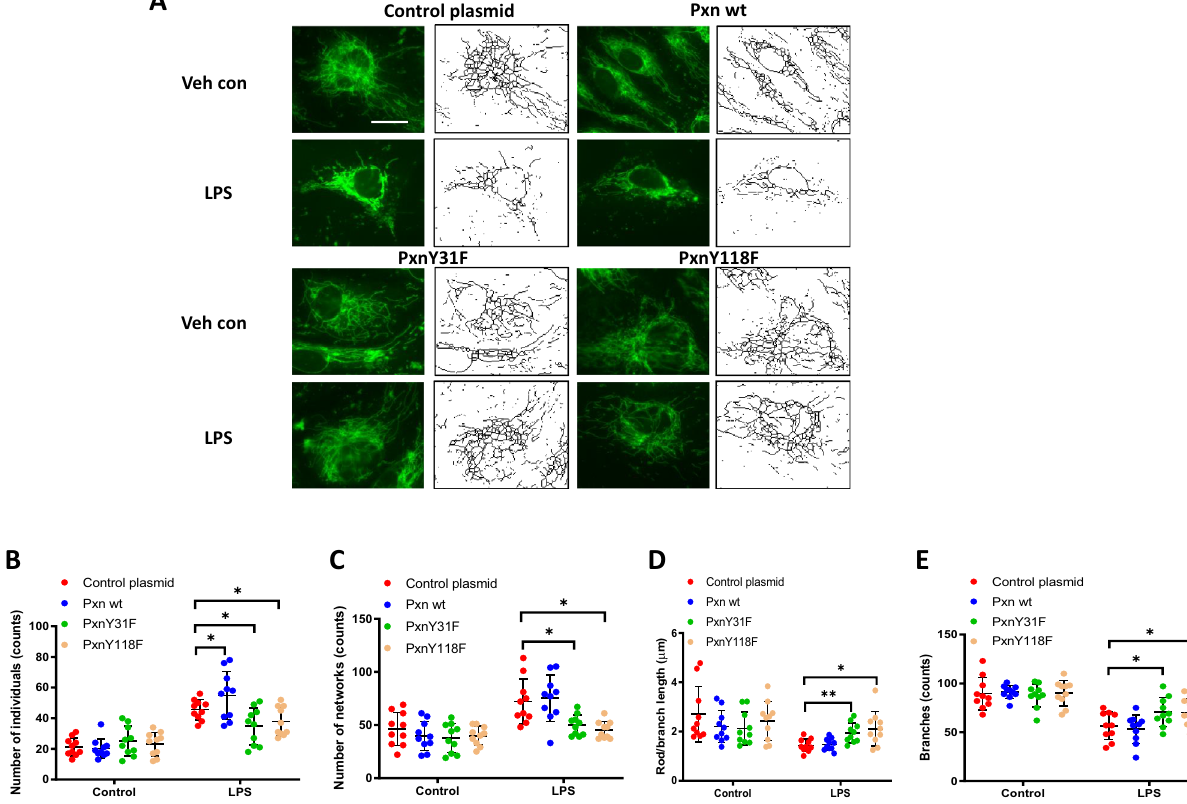
Figure 3. Paxillin mediates LPS-induced HLMVECs mitochondrial fission. ( A ) HLMVECs were transfected with Pxn wild type, PxnY31F, or PxnY118F plasmids. After 48 h of transfection, cells were stained with MitoTracker (50 nM, 10 min) before termination of LPS challenge (100 ng/ml, 12 h). Images were acquired by fluorescent microscopy and subjected to skeletonization by Image J software for the purpose of quantification as described in the Methods. Scale bar: 5 μm. ( B – E ) Mitochondrial dynamics was assessed by four major parameters of mitochondrial morphology, namely, number of individual fragments, number of networks, rod/ branch length, and branch counts. Data were presented as means ± SD, for number of individual fragments, *p < 0.05 compared with LPS control plasmids; for number of networks, *p < 0.05, compared with LPS control plasmid; for rod/branch length, *p < 0.05, **p < 0.01 compared with LPS control plasmid; for branch counts, *p < 0.05 compared with LPS control